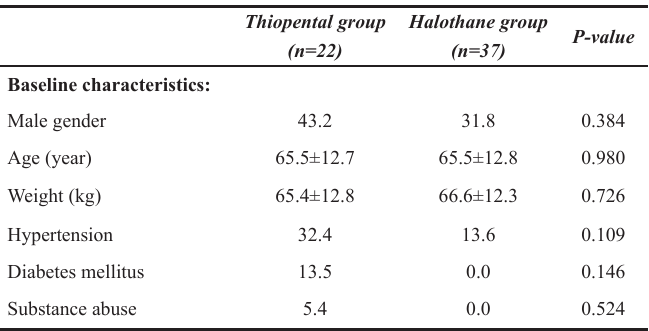
TABLE 1 - Demographic characteristics and medical data of the patients received thiopental and halothane.